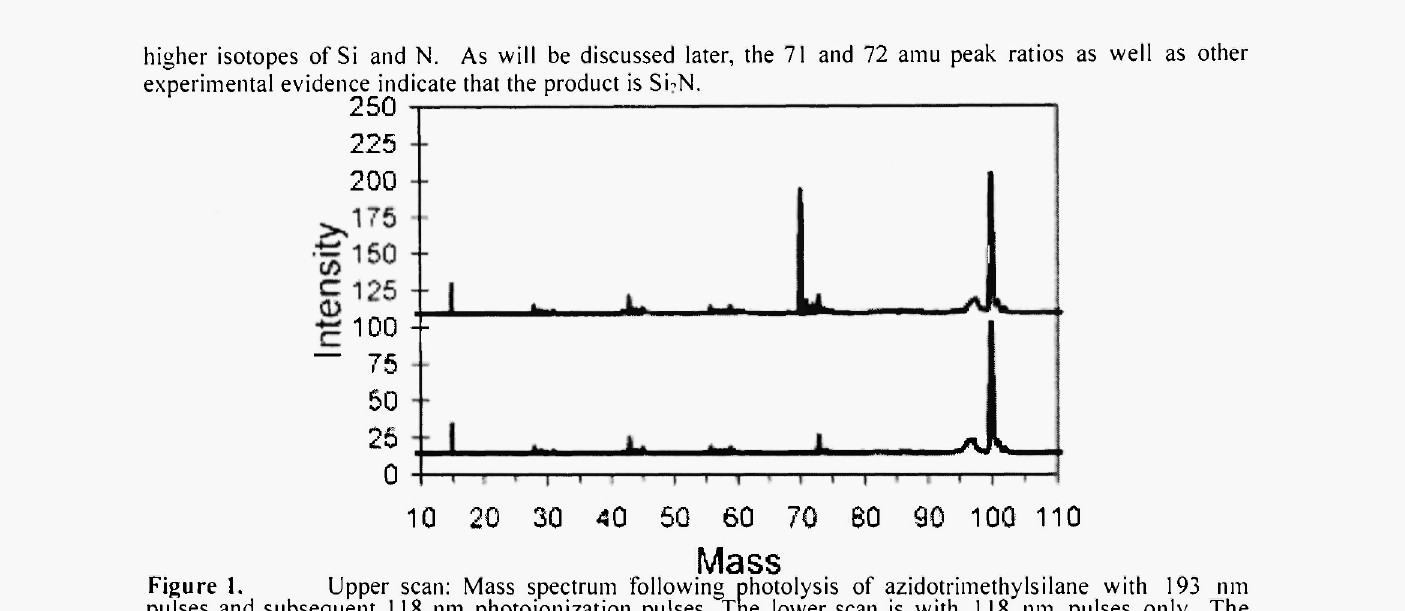
Figure 1. Upper scan: Mass spectrum following photolysis of azidotrimethylsilane with 193 nm pulses and subsequent 118 nm photoionization pulses. Tne lower scan is with 118 nm pulses only. The relatively large 100 amu product peaks, present with and without 193 nm photolysis, arise from the loss of a methyl group by the parent following 118 nm photoionization.